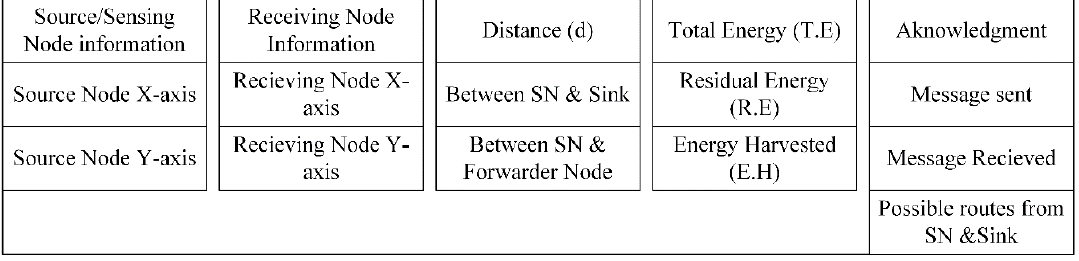
Figure 4. Hello Packet block diagram.